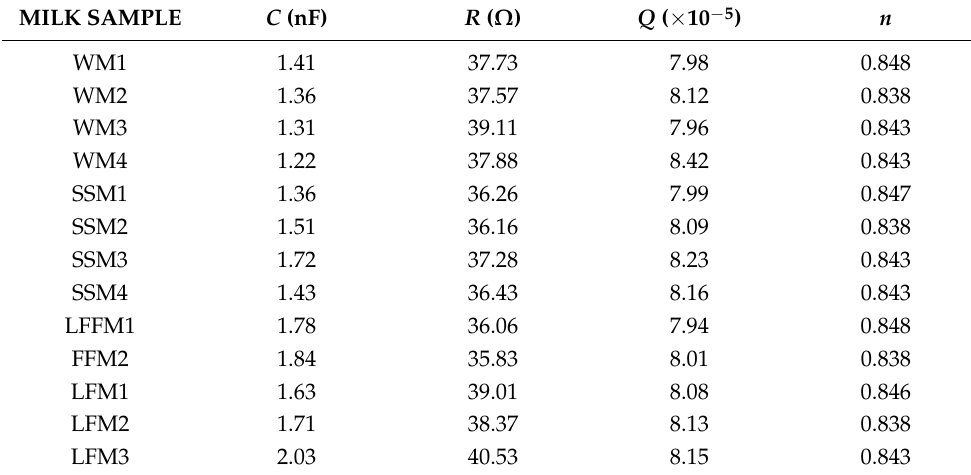
Table 3. Values of the components of the circuit in Figure 7, obtained by means of fitting operation on the data obtained with the measurements on milk samples.